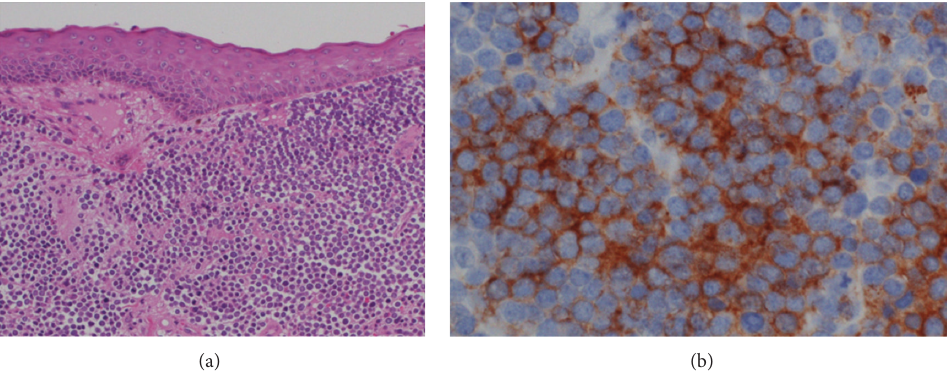
Figure 4: Representative histopathologic findings in the surgical specimen of the right upper eyelid. H-E staining showed small round cell tumor (a) ( × 100). Immunostaining with CD56 was positive (b) ( ×